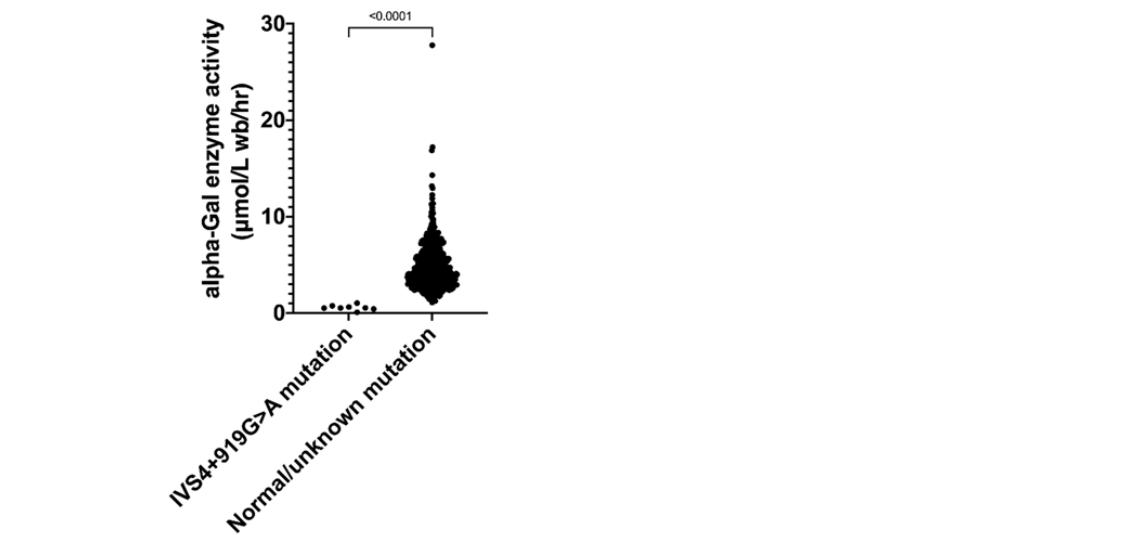
Figure 1. Scatter plot of alpha ‐ Gal enzyme activity. Patients with IVS4 + 919G > A mutation had significantly lower plasma enzyme activity compared to those with normal/unknown mutation.